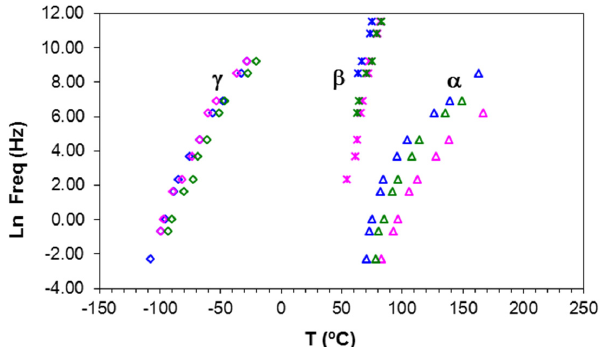
Figure 14. Relaxation map for PEI800-PLA5 (green), PEI2000-PLA5 (blue) and PEI2000-PLA20 (pink) at heating rate 2 °C/min: α -relaxation (triangles), β -relaxation (asterisks), γ -relaxation (rhombus).